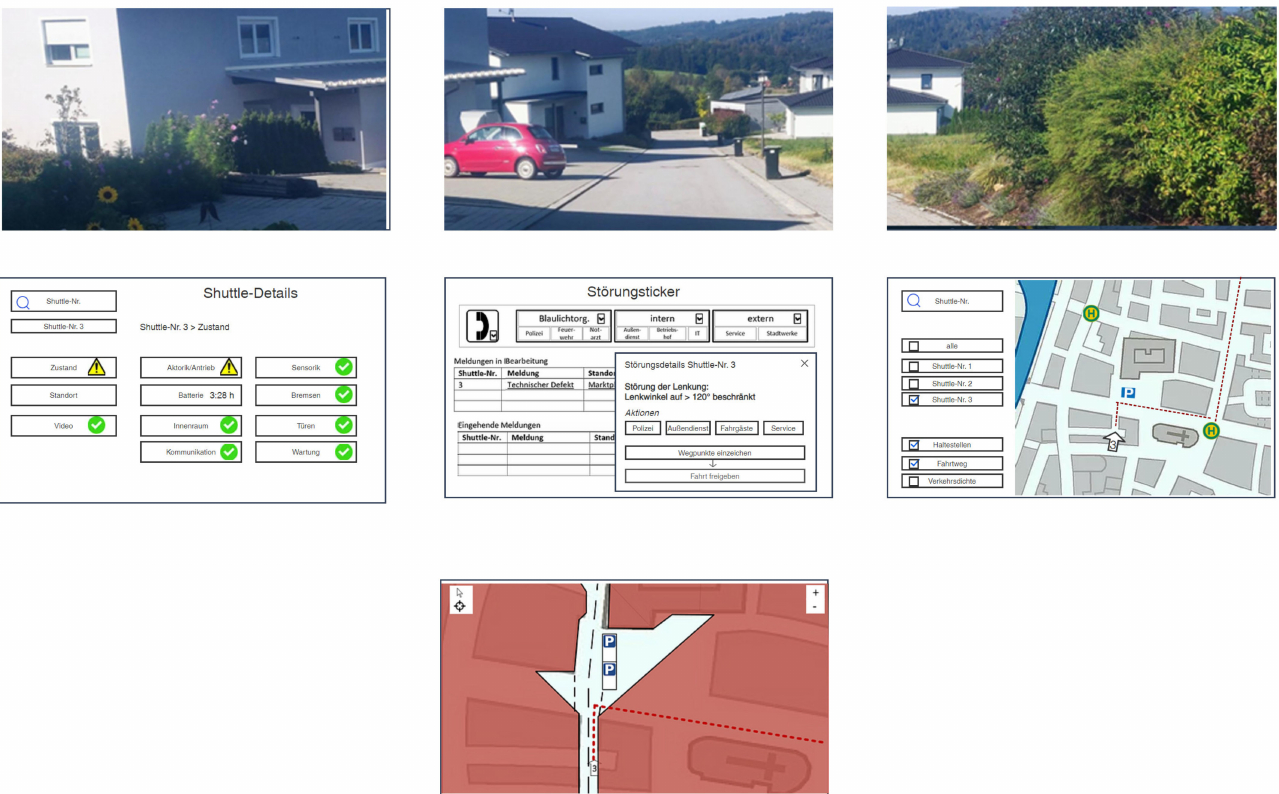
Figure 1. Overview of the prototype evaluated in this study. Each box represents a monitor, six of them are regular computer monitors that are operated with keyboard and mouse. The top row of monitors consists of three Video screens. The central row consists of (from left to right) the “details screen”, the “disturbances screen”, and the “map screen”. The bottom screen is the “touchscreen” embedded in the workstation’s desk is therefore operator with fingers or a stylus. The “details screen” contains a search bar on the top left corner and three navigation tabs reading “State”, “Position”, and “Video” below it. Next to them, different state-related categories are listed, such as “Actorics”, “Sensorics”, “Battery”, and “Brakes”. The “disturbances screen” provides a communication bar on top, and two tables below that make up the disturbances ticker. It consists of two sections, “Notifications in Progress” and “Incoming Notifications”. The pop-up window on the right shows details on the selected disturbance and steps to resolve it. The “map screen” contains a search bar on the top left corner, checkboxes to select specific shuttles below, and layers to be added to the map, such as “Stops” and “Trajectory”. The “touchscreen” shows the original trajectory as a red dotted line. The area where waypoints can be set is shown in white, while no waypoints can be set in the red